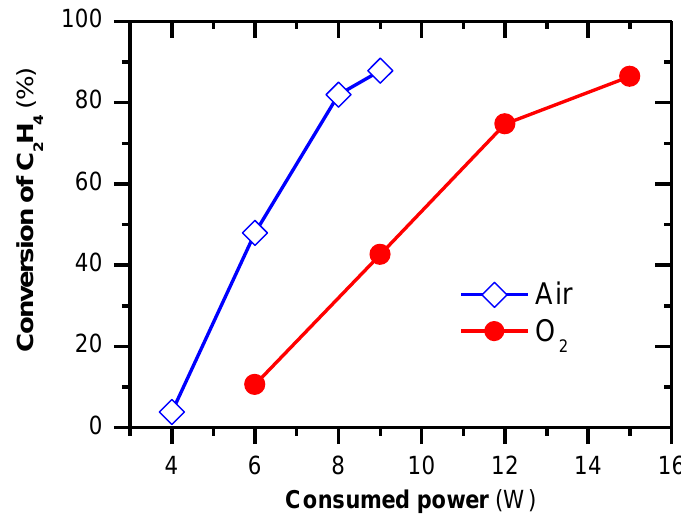
Figure 4. A comparison between air and oxygen as an oxidizing gas in the feed under various consumed power (total flow rate of 2 L/min included 30 ppm C 2 H 4 ).